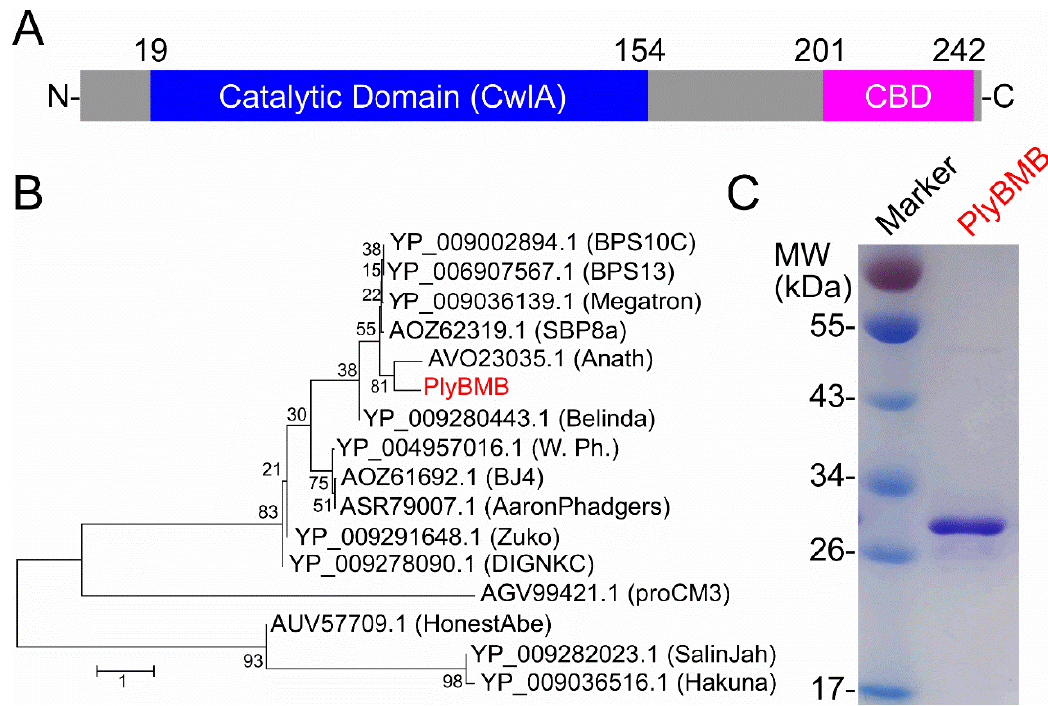
Figure 6. Bioinformatic analysis and expression of PlyBMB. ( A ) Domain composition of PlyBMB. The locations of the catalytic domain and the cell wall-binding domain (CBD) are shown. ( B ) Phylogenetic analysis of PlyBMB with the other endolysins encoded by Bacillus phages. Only the endolysins showing more than 50% similarity with PlyBMB were used for phylogenetic analysis. The GenBank accession number of the endolysins and the names of the phages that encoded the endolysins are shown. ( C ) Expression and purification of PlyBMB.